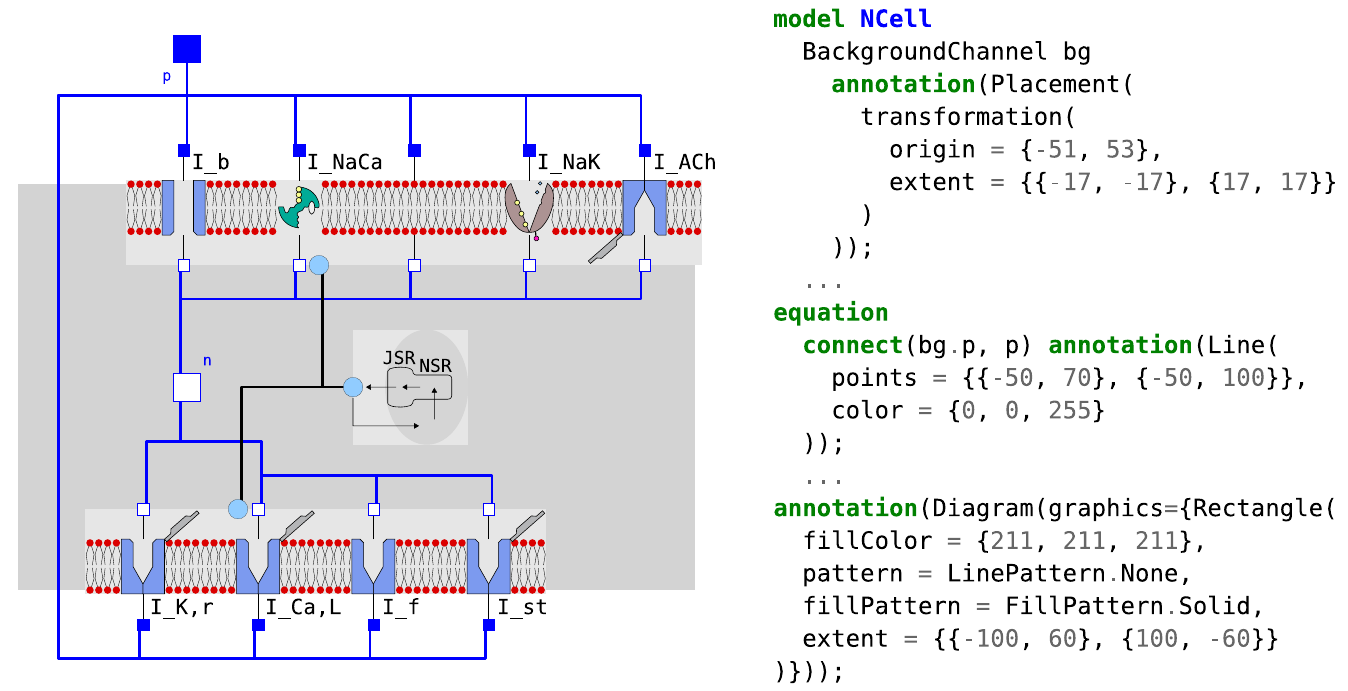
Fig 6. Graphical representation of the N cell model. Left: Diagram resulting from drag and drop composition of model components (InaMo version 1.4.1). Right: Automatically generated embedding of graphical annotations in the model code showing the placement of the background channel ( annotation(Placement ( ... )) ), the connection line to the positive pin ( annotation(Line( ... )) ) and the definition of the gray rectangle in the background ( annotation (Diagram( ... )) ).